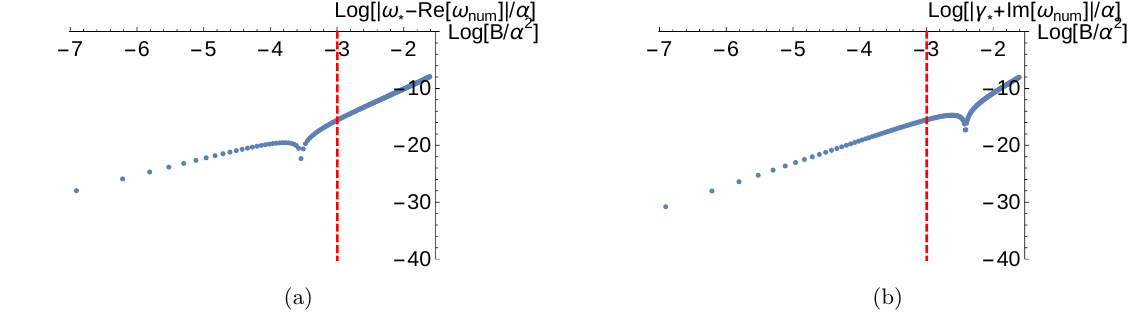
Figure 5 : Plots of the logarithm of the absolute di(cid:11)erence between our analytic expression for the position of the hydrodynamic mode and the numerical position for the dyonic black hole against the magnetic (cid:12)eld at (cid:26)=(cid:11) 2 = 1 = 20. The red dashed line indicates the point where B = (cid:26) . Left: the di(cid:11)erence in the real part. The trough in the data indicates the point where our analytic result almost coincides with the numerical result. On the left of this trough the di(cid:11)erence grows as B 3 while on the right it behaves as B 5 . Right: the di(cid:11)erence in the imaginary part. Again, the trough in the data indicates the point